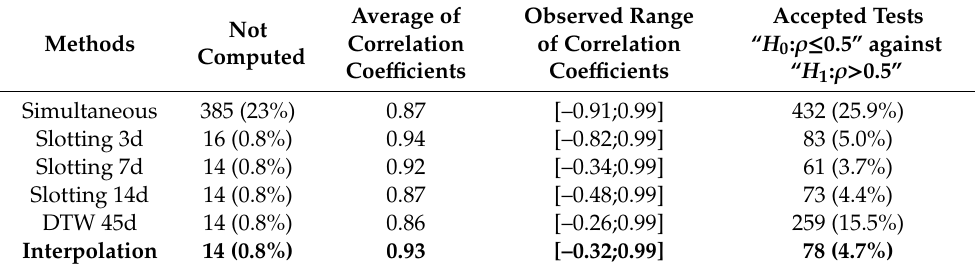
Figure 4. Illustration of four different cases when comparing Sentinel-2 (squares) and PlanetScope (circles) time series: ( a ) Excellent match for all the tested methods; ( b ) excellent match for the interpolation and the slotted methods only; ( c ) estimation not possible for the simultaneous method; ( d ) poor results for all of the methods because of a lack of repeated observations. The slotting method with the different bin sizes produced similar results, thus only the seven-day bin size is shown here. The filled circles and squares represent the observations while the hollow circles and squares are the interpolated values. The dashed lines represent the simultaneous observations. Table 3. Comparison of the occurrences of missed estimations, of the average and standard deviation of the CCs, and occurrences of accepted hypothesis “ H 0 : ρ ≤ 0.5” against the alternative hypothesis “ H 1 : ρ > 0.5” for the 1670 parcels.